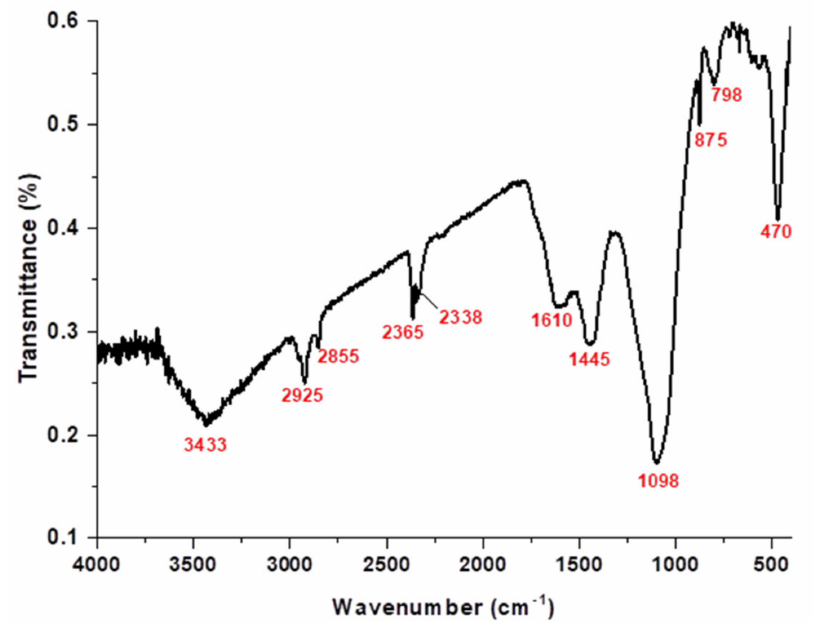
Figure 3. FTIR analysis of sheep dung ash.